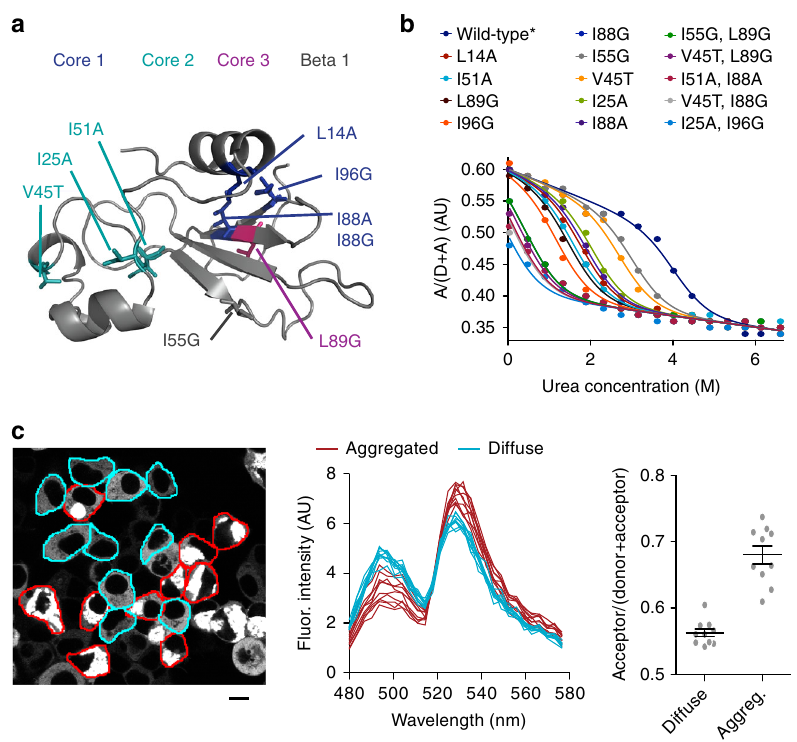
Fig. 2 FRET reports on barnase foldedness and aggregation. a Bait protein barnase structure is shown (PDB ID 1A2P) with the location of destabilizing mutations used to tune K f (and thus Δ G F ). b Urea denaturation curves, assayed by FRET, are shown of barnase constructs expressed in mammalian lysate fi tted to a two-state unfolding model (one representative replicate per mutant of n = 3). c A confocal micrograph image of representative cells expressing a destabilized barnase variant (I25A, I96G) in HEK293T cells. Scale bar = 10 µ m. The wild-type barnase variant does not form visible aggregates. The middle graph shows fl uorescence spectra (excitation 405 nm) for cells with only diffuse biosensor vs. cells with visible aggregates. The right graph shows a proxy measure for FRET of these cells (means ±